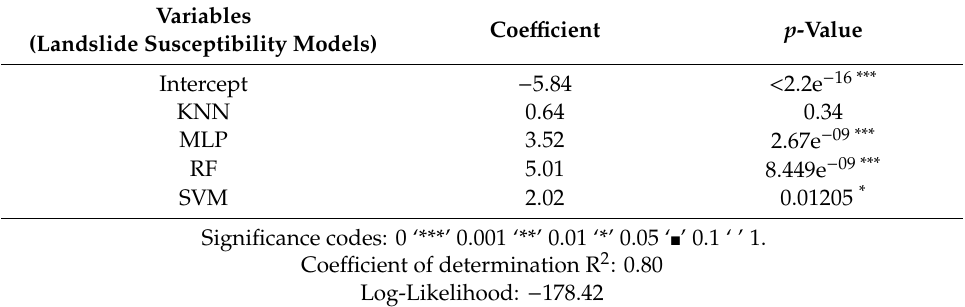
Table 4. Outcomes of the logistic regression